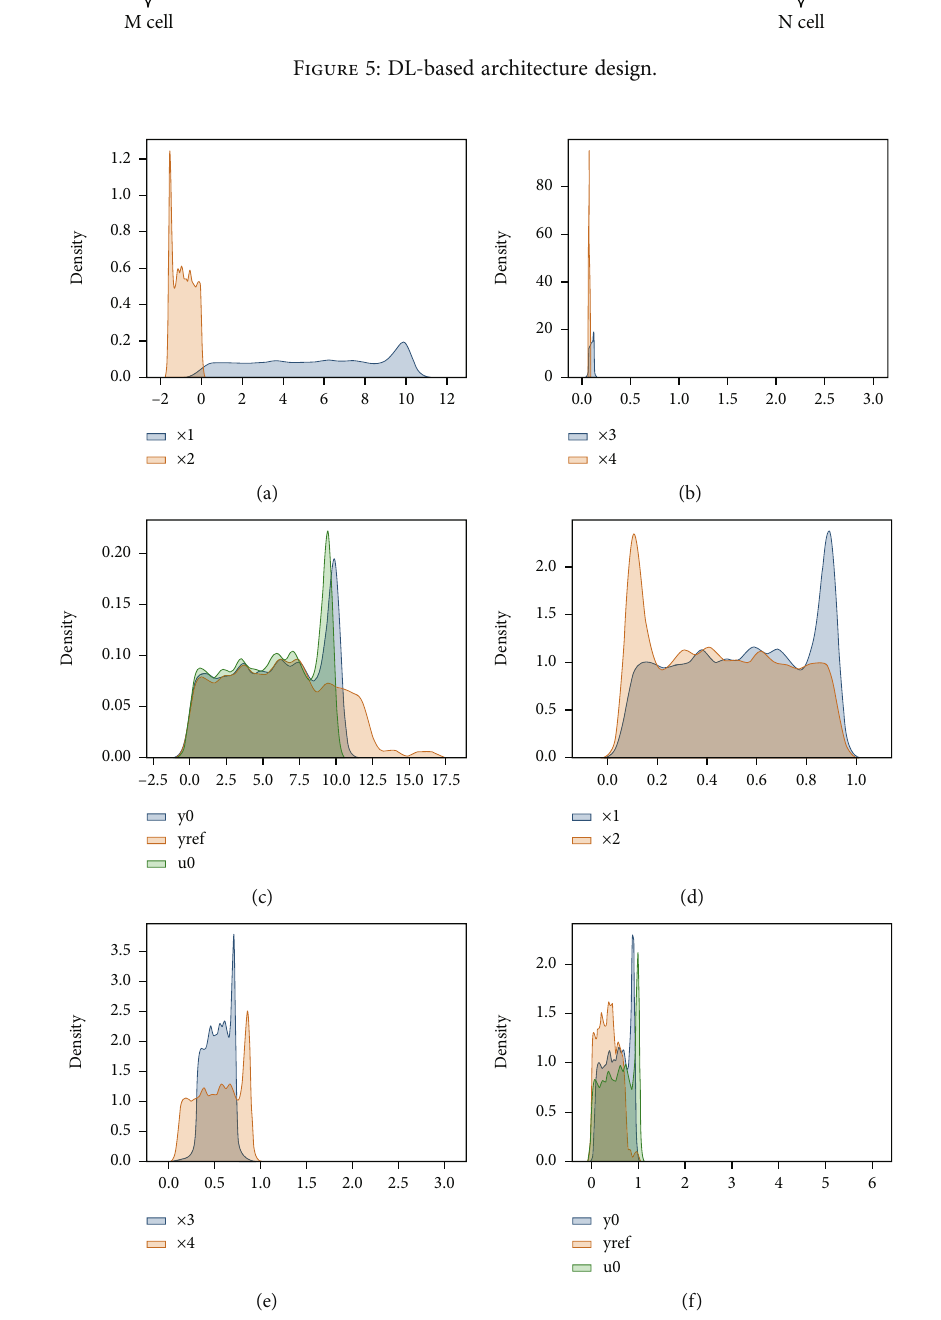
Figure 6: The distribution of dataset. (a – c) The distribution of original data and (d – f) the distribution of normalized